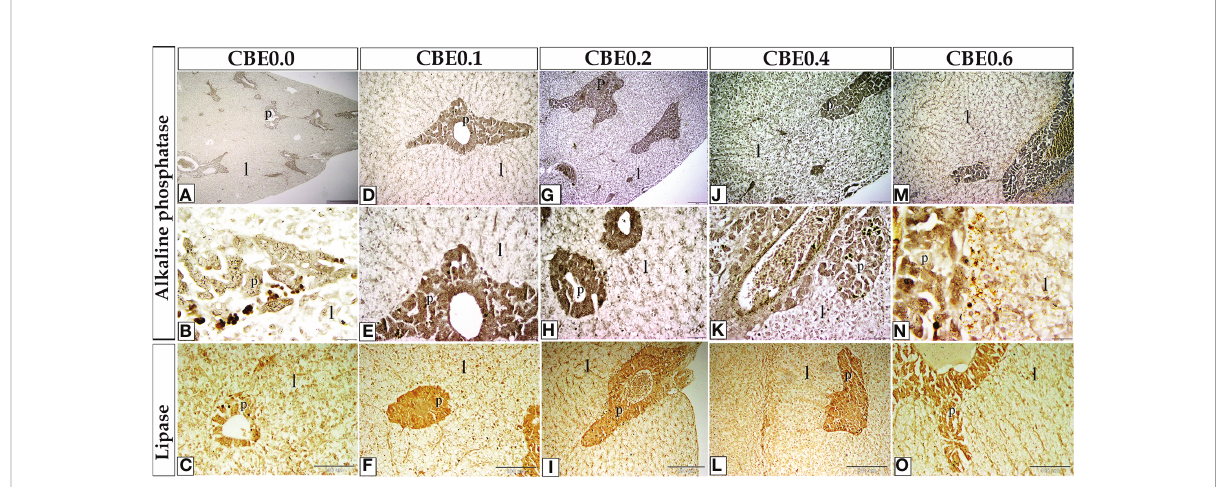
FIGURE 10 The staining af fi nity of frozen sections of liver stained with alkaline phosphatase (A – N) and lipase enzymes (C, F, I, L, O) varied in response to different dosages of CBE. When compared to the control group, the treatment groups demonstrated an increase in alkaline phosphatase and lipase content staining within the liver cells (l) and pancreas